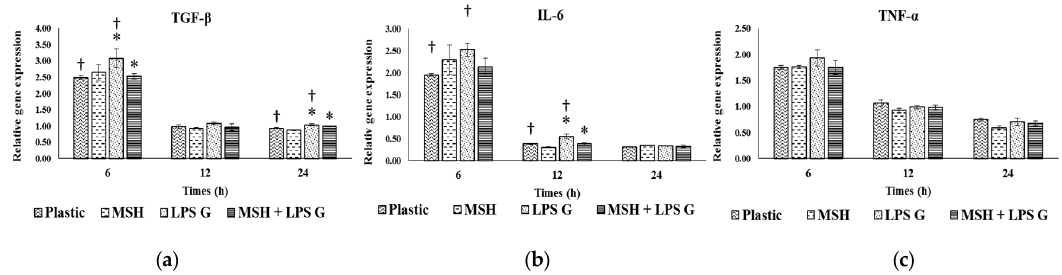
Figure 4. Gene expression of transforming growth factor-beta (TGF- β ) ( a ); interleukin-6 (IL-6) ( b ); tumor necrosis factor (TNF- α ) ( c ) in human oral epithelial cells. Relative mRNA levels were